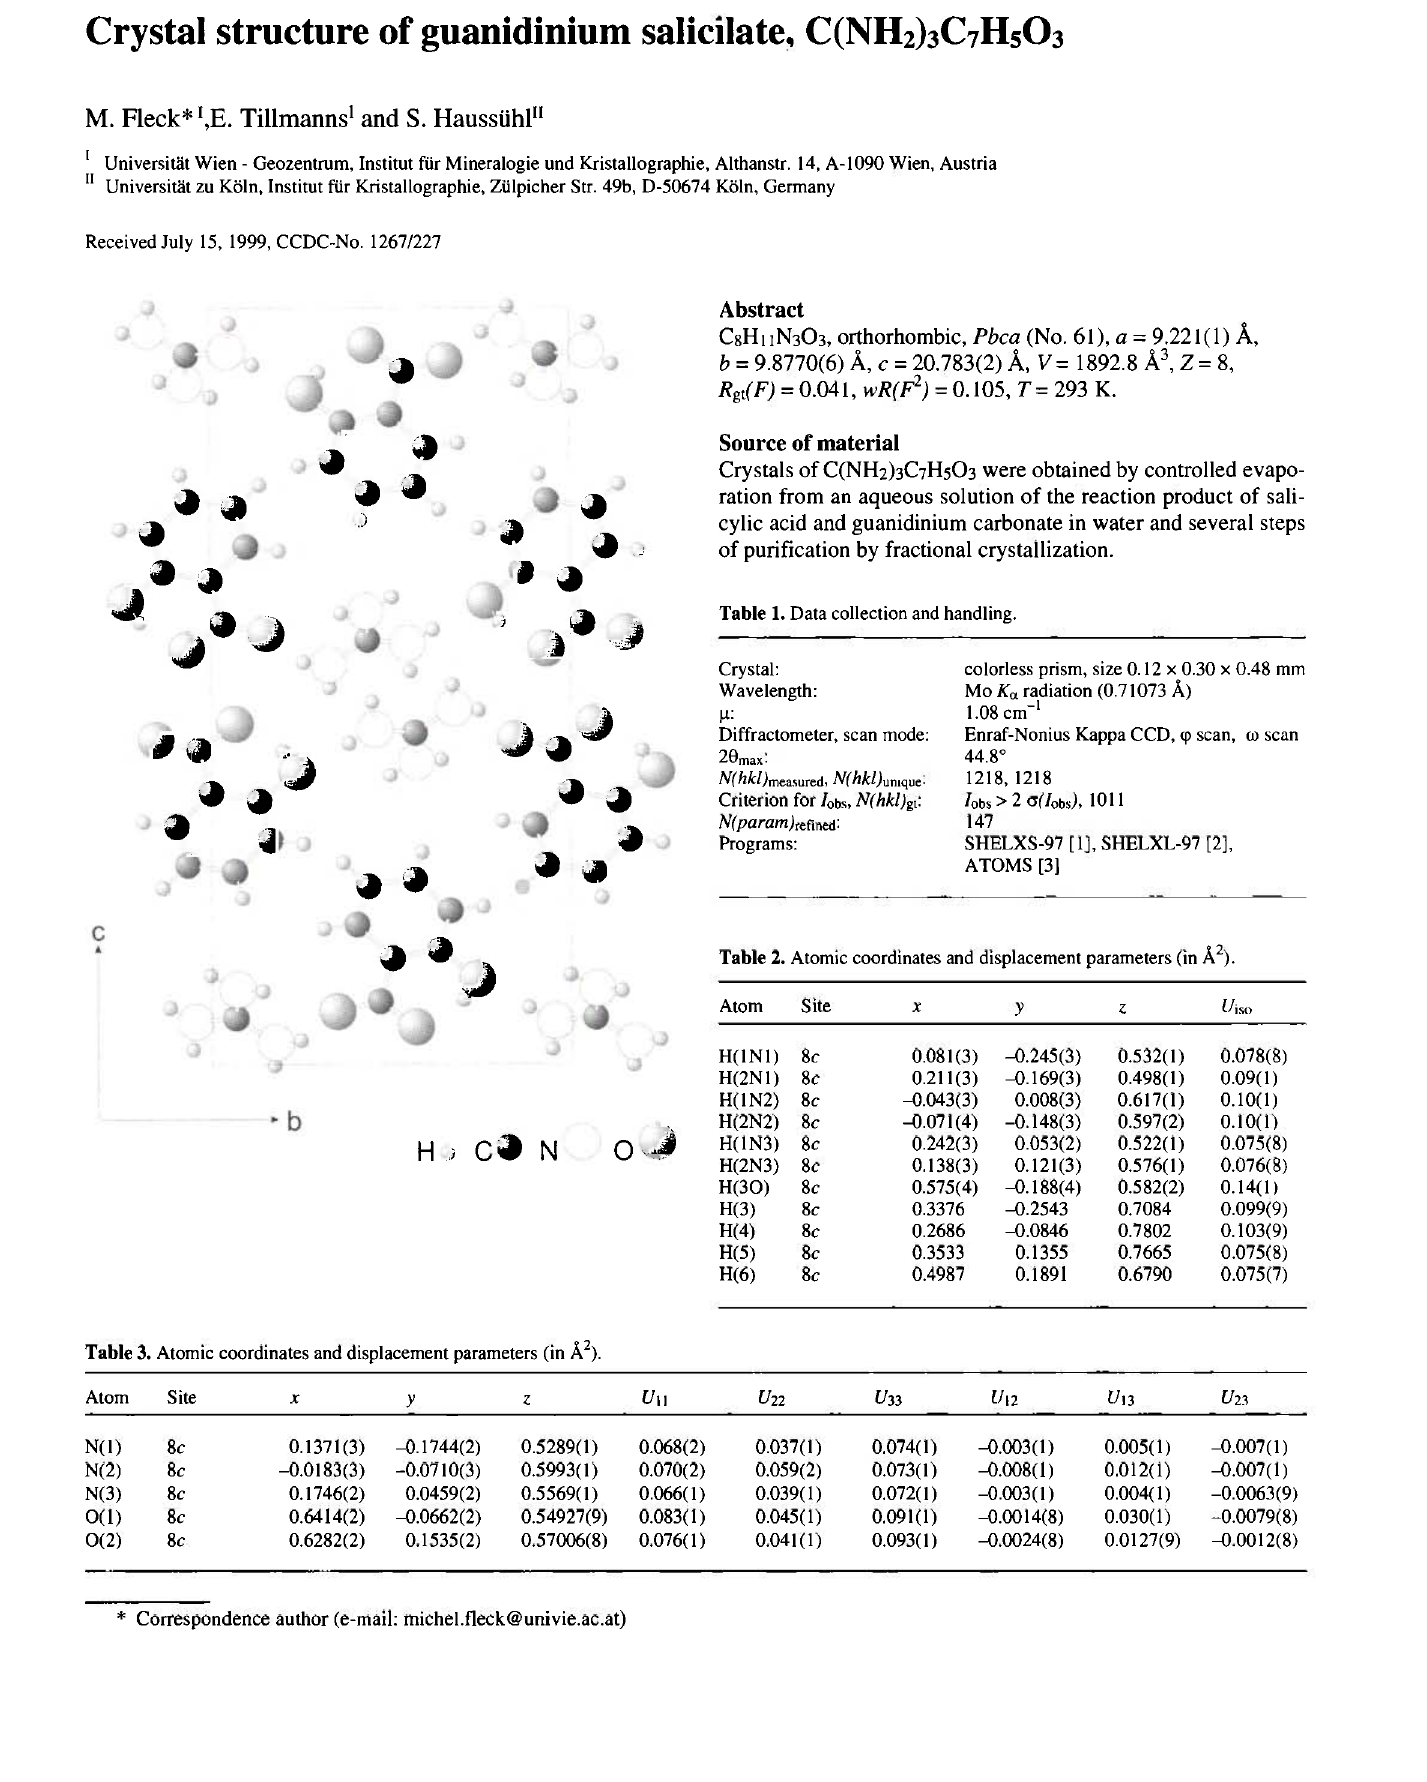
Table 3. Atomic coordinates and displacement parameters (in Ä 2 ).